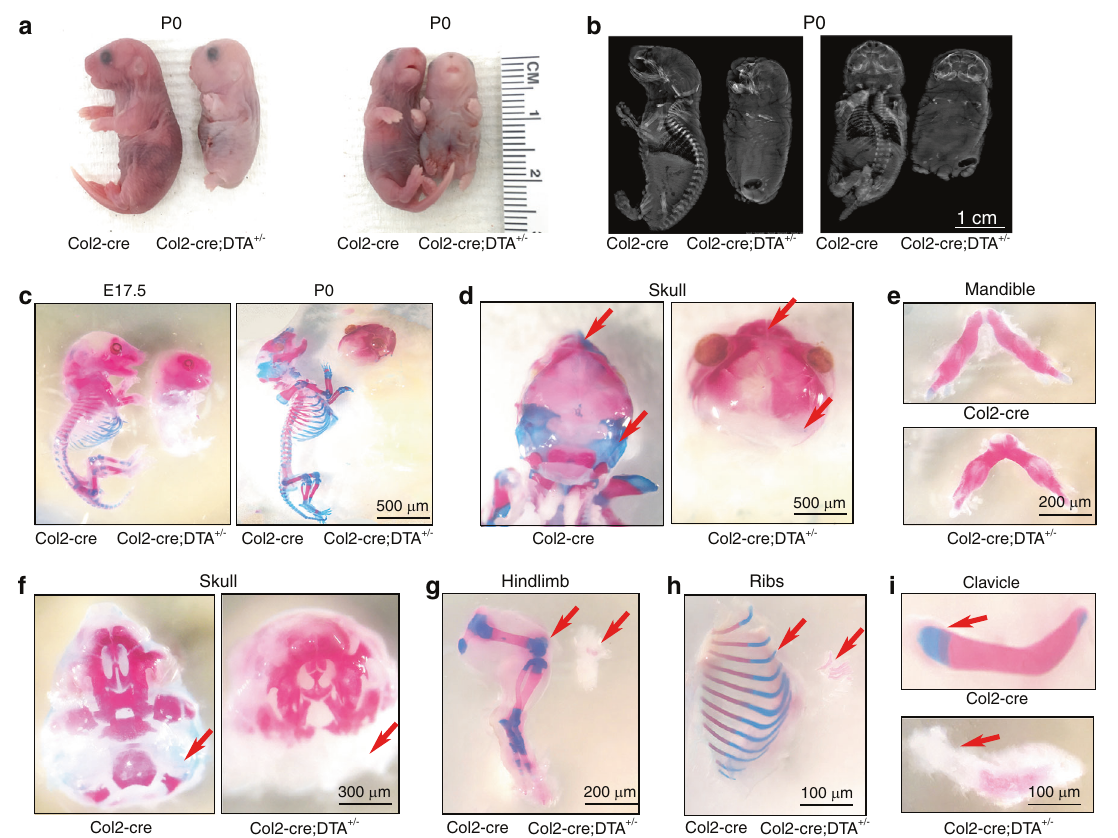
Fig. 2 Ablation of Col2 + cells causes lethality in newborn mice due to the absence of endochondral bone and cartilage. a Gross appearance of Col2-cre and Col2-cre;DTA + / − mice at P0. The mutant mouse is small and has an extremely short four-limb pattern. b X-ray of P0 wild-type and mutant embryos. c Skeletons of Col2-cre and Col2-cre;DTA + / − mice at E17.5 and the newborn stage. Embryos and newborns were double stained with Alizarin red/Alcian blue. d Alizarin red/Alcian blue staining of skulls of Col2-cre and Col2-cre;DTA + / − newborns. Red arrow, complete loss of cartilage in Col2-cre;DTA + / − mice. e Alizarin red/Alcian blue staining of the mandibles of Col2-cre and Col2-cre;DTA + / − newborn mice. f Interior view showing the lack of mandibles in the skulls of Col2-cre and Col2-cre;DTA + / − newborn mice. Red arrow, bone loss in Col2-cre;DTA + / − mice. g Hindlimbs of Col2-cre and Col2-cre;DTA + / − newborn mice. Red arrow, bone loss in Col2-cre;DTA + / − mice. h Ribs of Col2-cre and Col2-cre;DTA + / − newborn mice. Red arrow, bone loss in Col2-cre;DTA + / − mice. i Clavicles of Col2-cre and Col2-cre;DTA + / − newborn mice. Red arrow, partial clavicle loss in Col2-cre;DTA + / − mice. n = 6 mice per condition; three independent